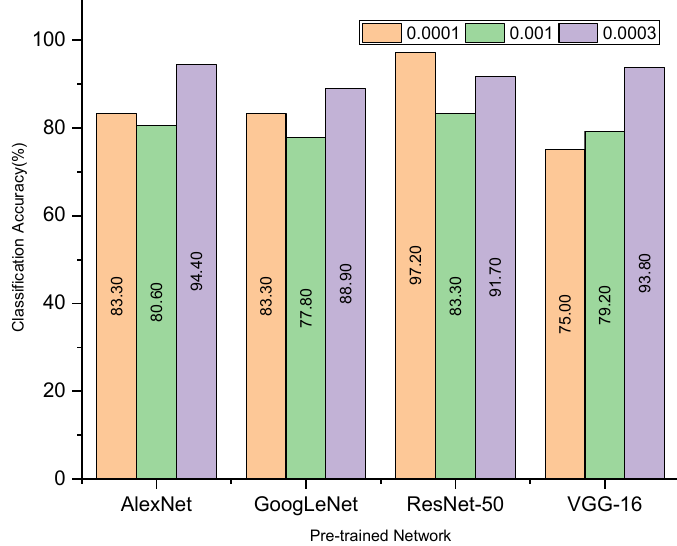
Figure 10. Pretrained network performance at various learning rates. Figure 10 indicates that the performance of each pretrained network changes as the learning rate changes. AlexNet, GoogLeNet and VGG-16 each obtained a highest accuracy of 94.4%, 88.9% and 93.8%, respectively, at a learning rate of 0.0003. ResNet-50, on the